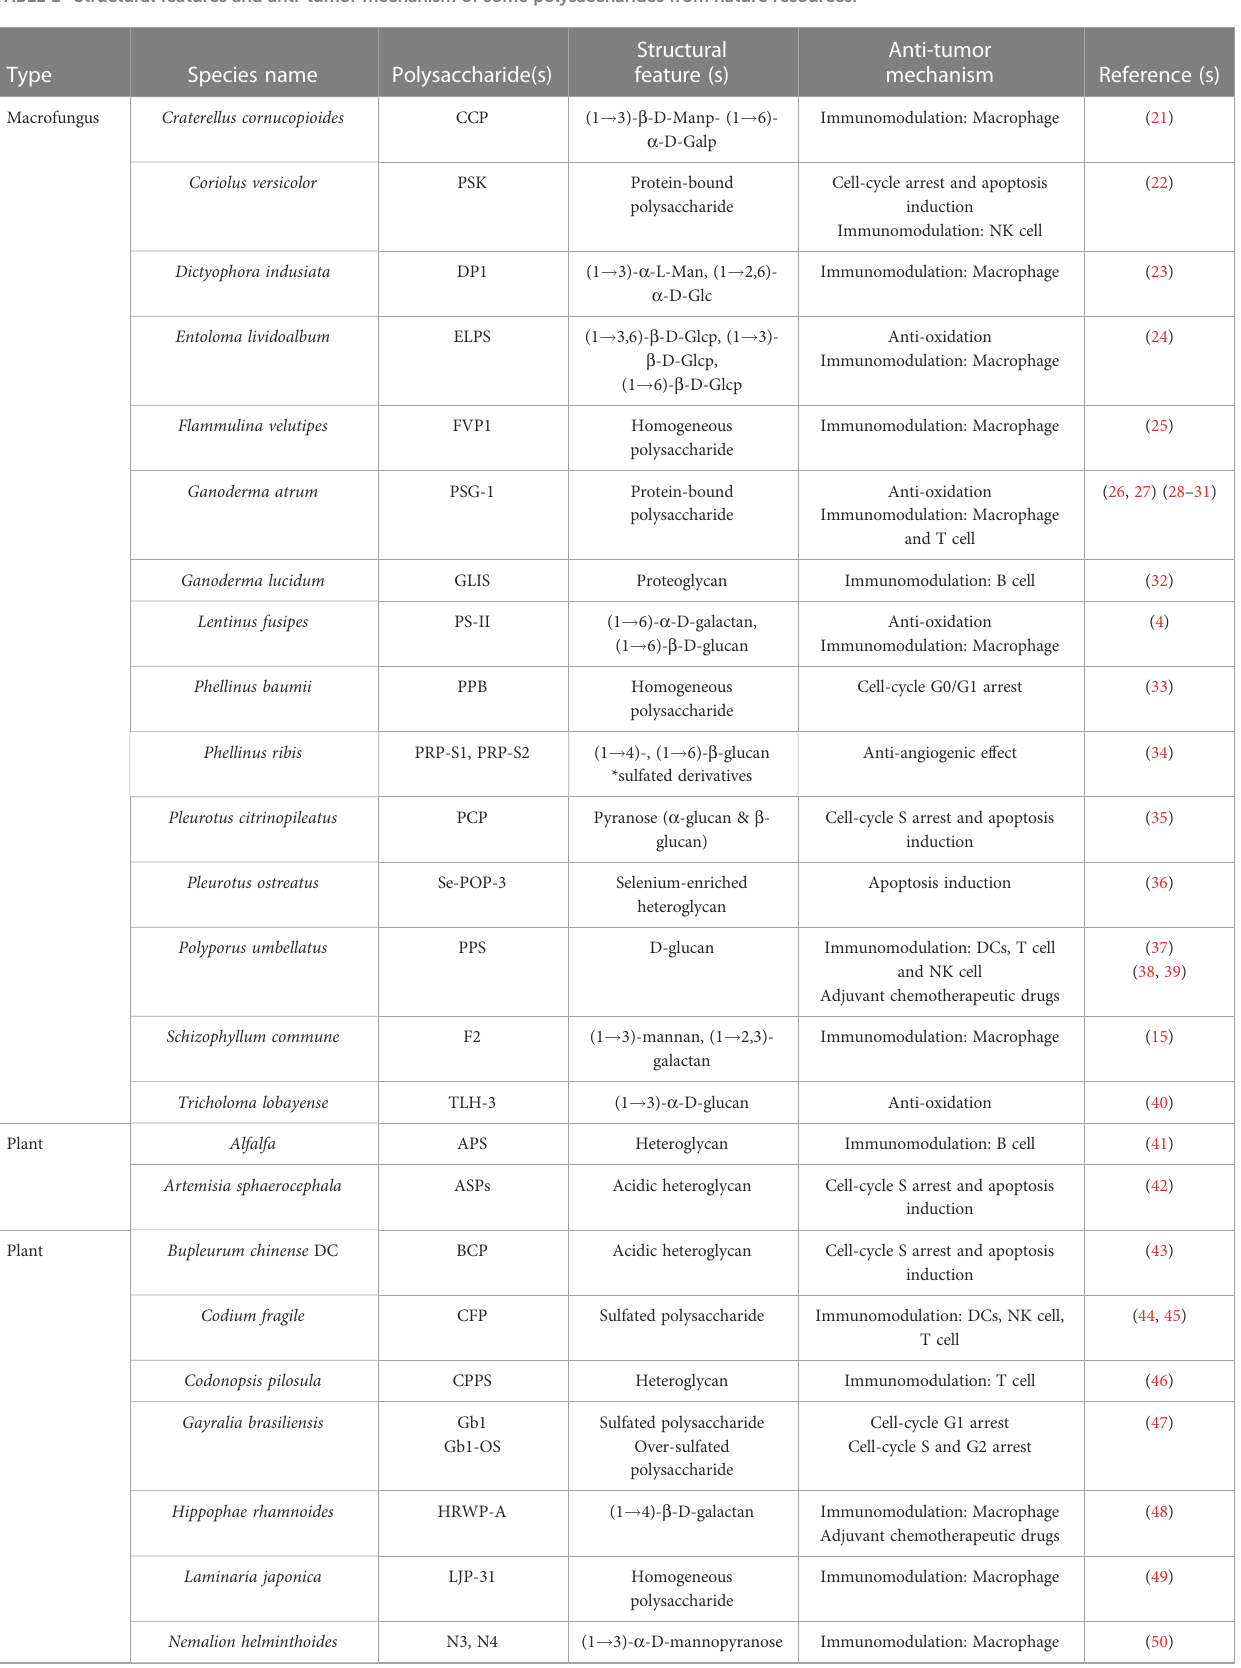
TABLE 1 Structural features and anti-tumor mechanism of some polysaccharides from nature